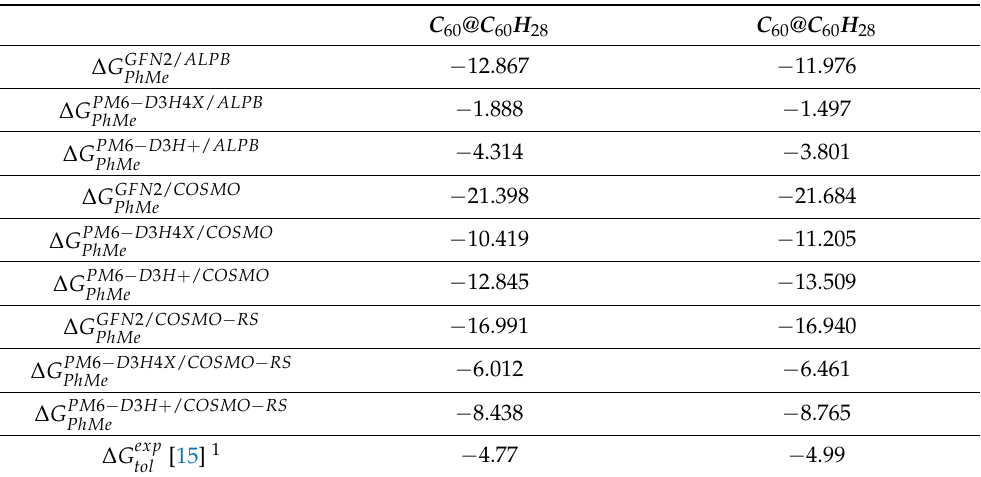
Table 3. Gibbs free energies (kcal/mol) for the formation of buckycatcher fullerene complexes according to several semi-empirical methods using several solvation models. Conformer-averaged data with conformational entropy were